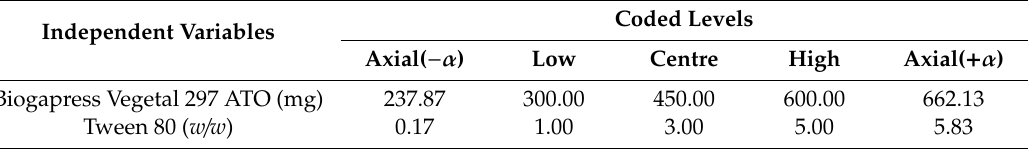
Table 1. Independent variables with high and low